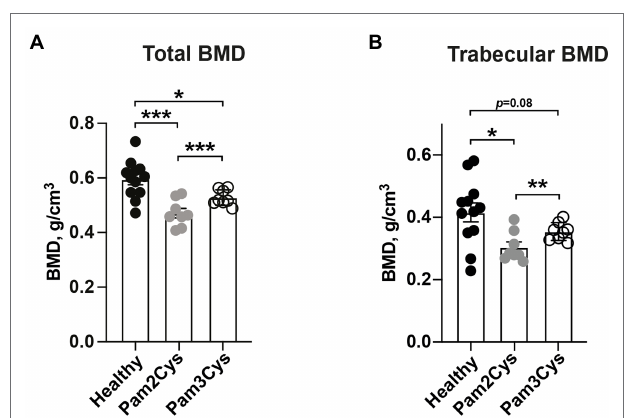
FIGURE 3 | The diacylated lipid-moiety of the synthetic lipopeptide, Pam2Cys, is more potent in inducing bone resorption than the triacylated lipid-moiety, Pam3Cys. Graphs showing quantitative evaluations of (A) total- and (B) trabecular BMD (g/cm 3 ) of femoral mice bone ( n = 8–12/group) on day 7 post i.a. knee injection with either Pam3Cys or Pam2Cys, or PBS collaterally in healthy control mice. Data were pooled from four independent experiments. Statistical evaluations were performed using the Paired t test between Pam2Cys and Pam3Cys injected knee joints (A,B) or Mann–Whitney U test between healthy control mice and Pam2Cys or Pam3Cys injected knee joints (A,B) , with data expressed as the mean ± SEM (* p < 0.05, ** p < 0.01, and *** p <